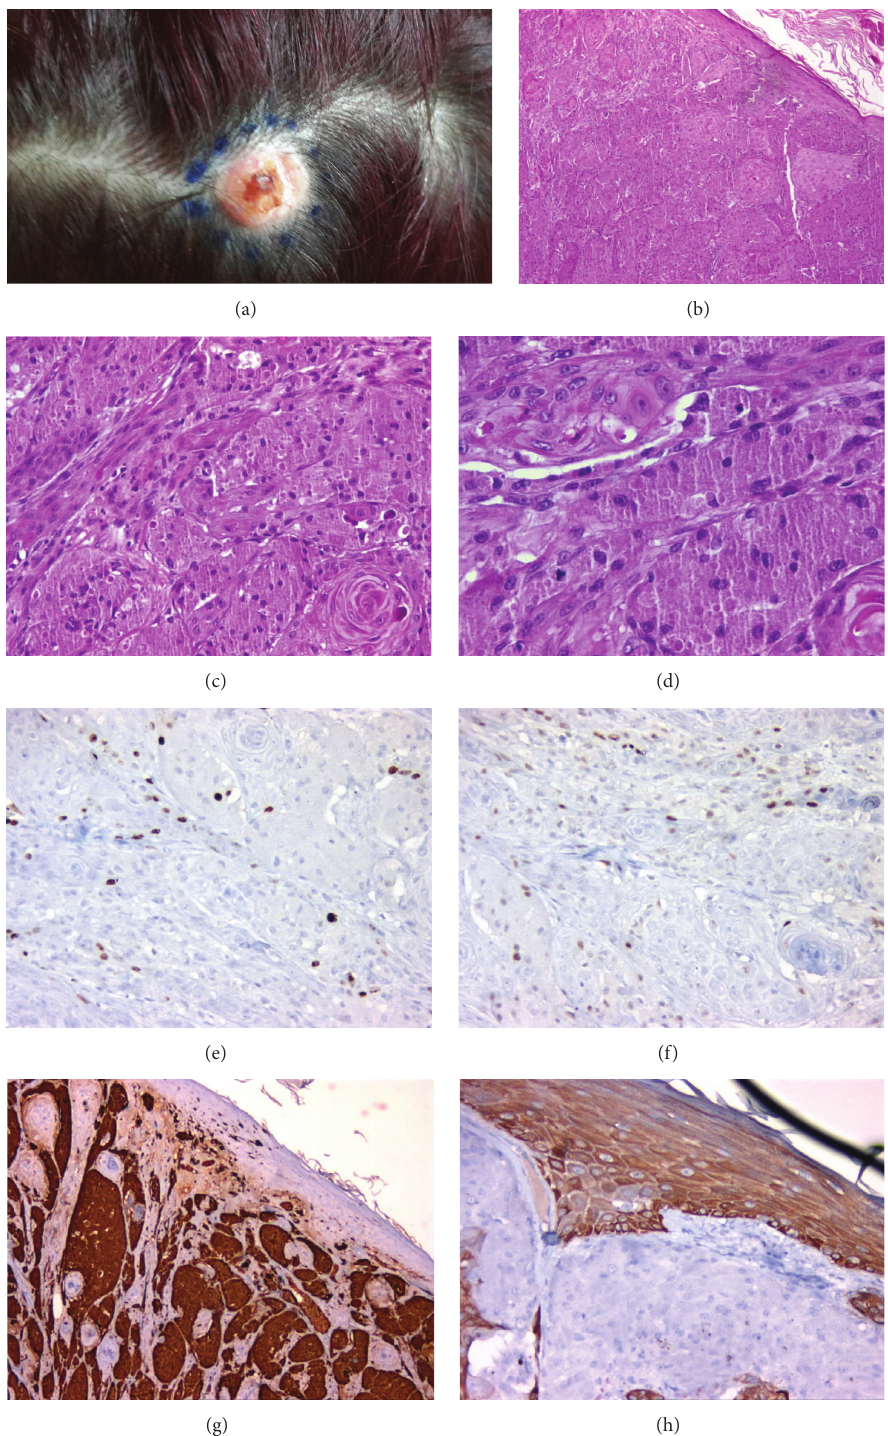
Figure 2: (a) Subcutaneous mass on the vertex of the scalp with ulcerated surface. (b) Reactive pseudoepitheliomatous hyperplasia of epidermis (H&E, × 100). (c) Polygonal tumor cells forming nests ( × 200). (d) Tumor cells with large eosinophilic granular cytoplasm and oval nucleus with nucleoli (H&E, × 400). (e) Tumor cells showing approximately 6% Ki-67 proliferation index ( × 200). (f) Tumor cells expressing p53weaklyandmildly( × 200).(g)TumorcellsexpressingS100proteindiffuselyandstrongly.(h)Tumorcellsimmunohistochemicallynegative for cytokeratin AE1/AE3 ( ×